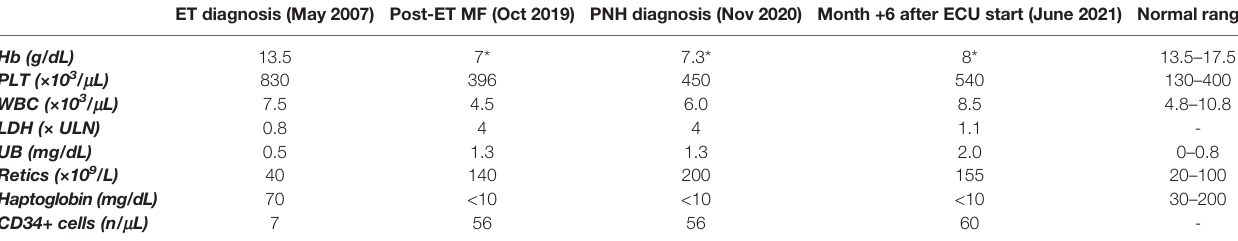
TABLE 1 | Laboratory parameters at different time points of the clinical history of the